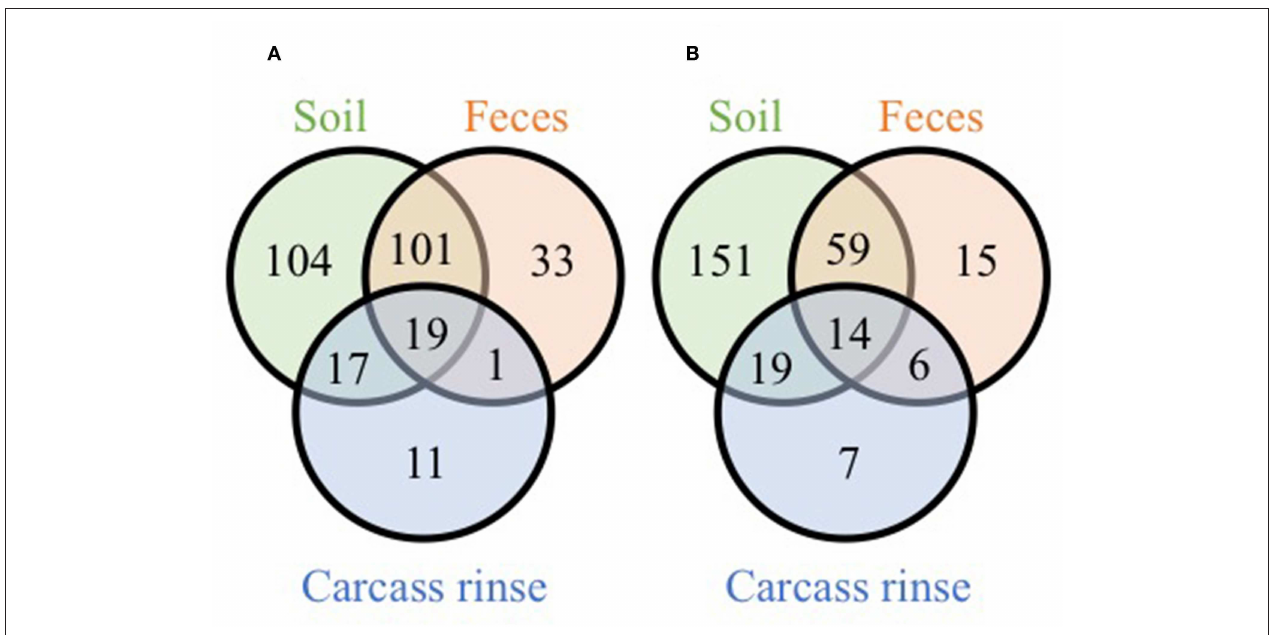
FIGURE 4 | Venn diagrams of shared genus-level OTUs from soil, fecal and pre-storage WCR microbiomes from farm 1 (A) and farm 2 (B)